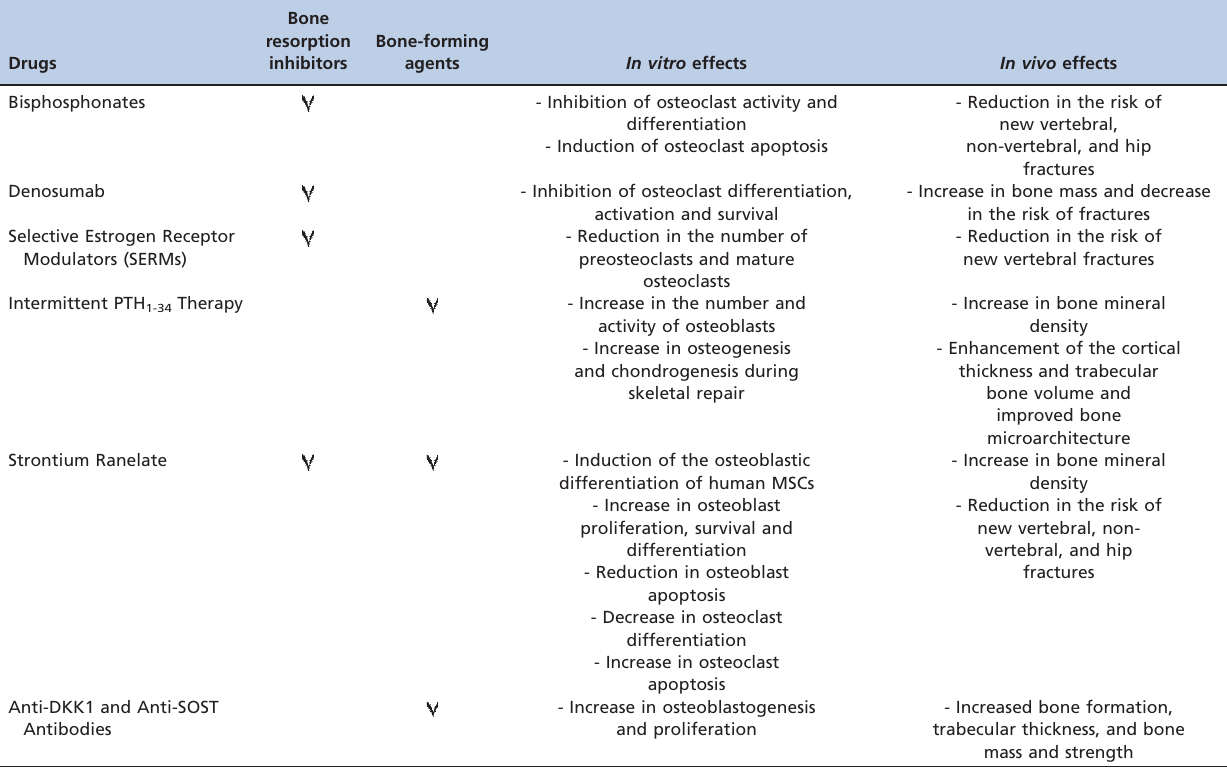
Table 1 - Comparisons of the principal drugs used in bone